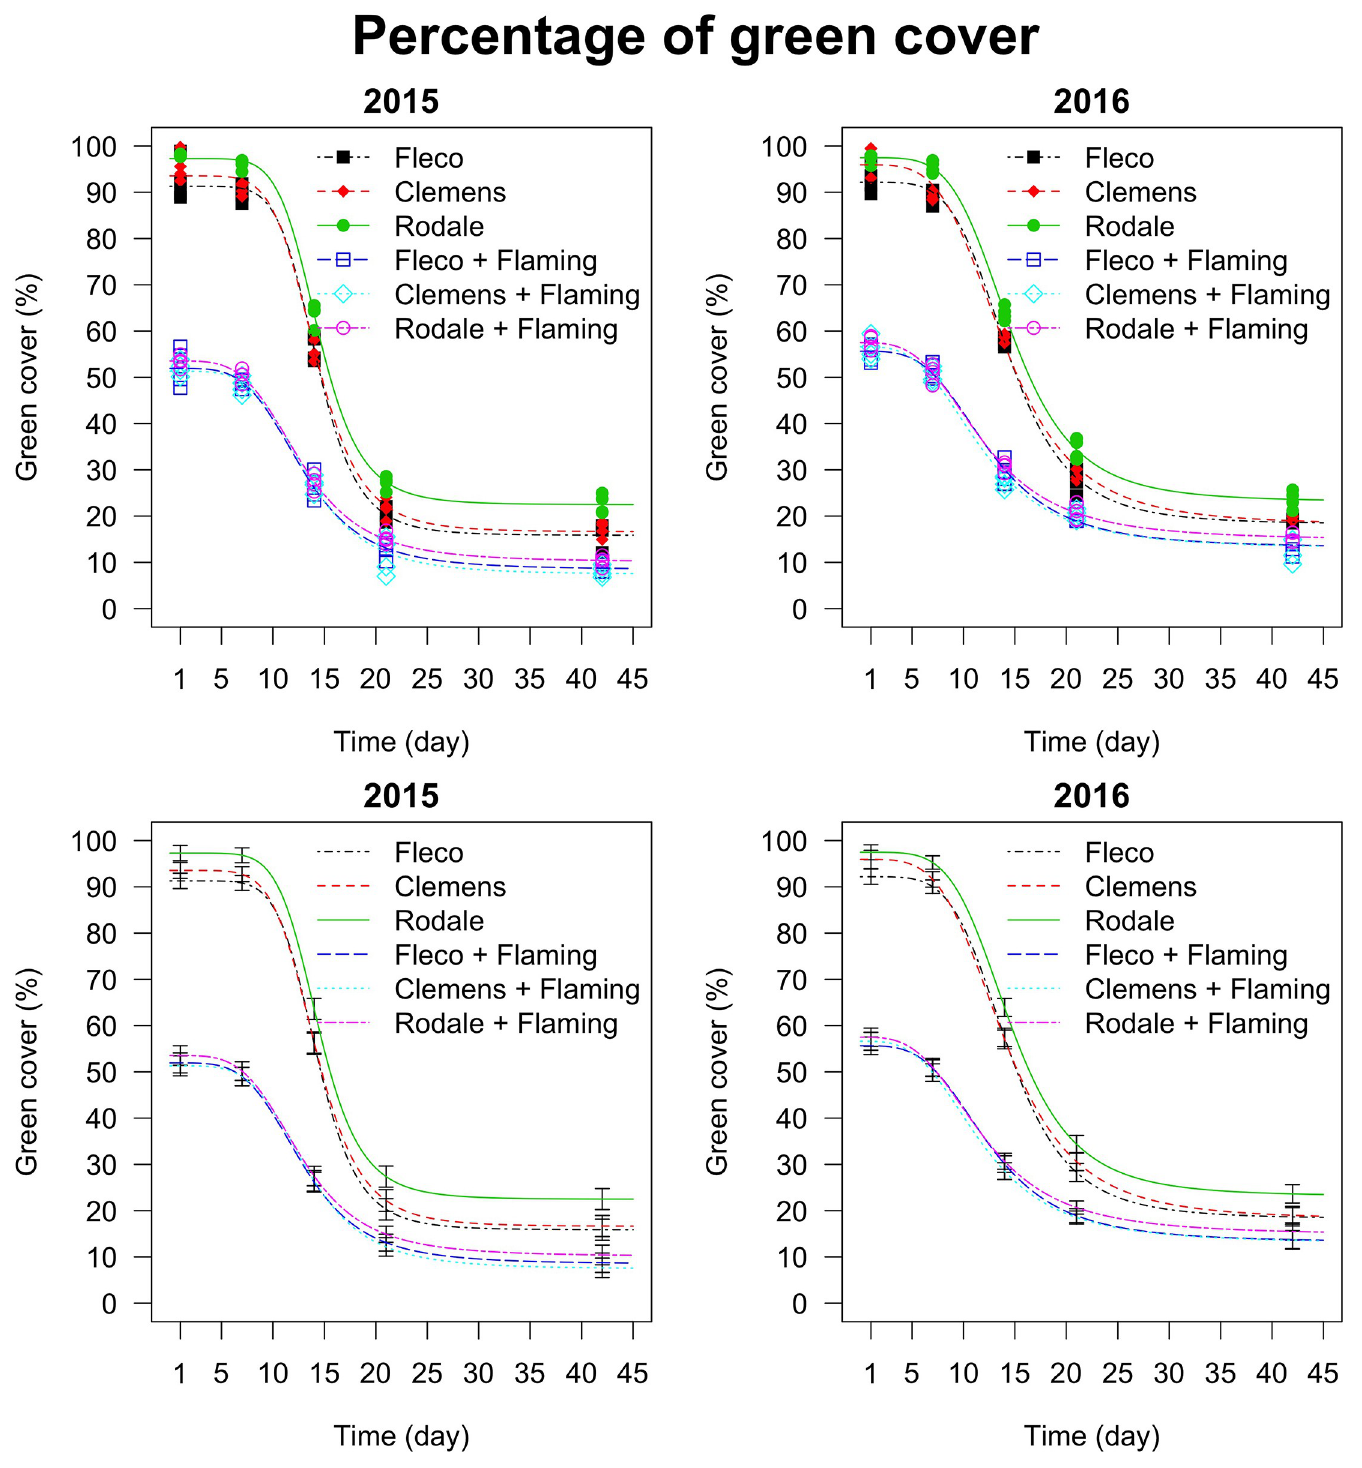
Fig 7. Percentage of green cover as affected by time (days after termination) and by the interaction between the type of roller (Fleco, Clemens and Rodale) and the flaming factor (if applied or not), in 2015 and 2016 growing seasons. All the data points and the model-based standard errors are reported, respectively, in the top and bottom graphs. The parameters of the curves (Eq 1) are reported in Table 2. Degrees of freedom: 96. The percentage of green cover before the termination was 100% in all plots.